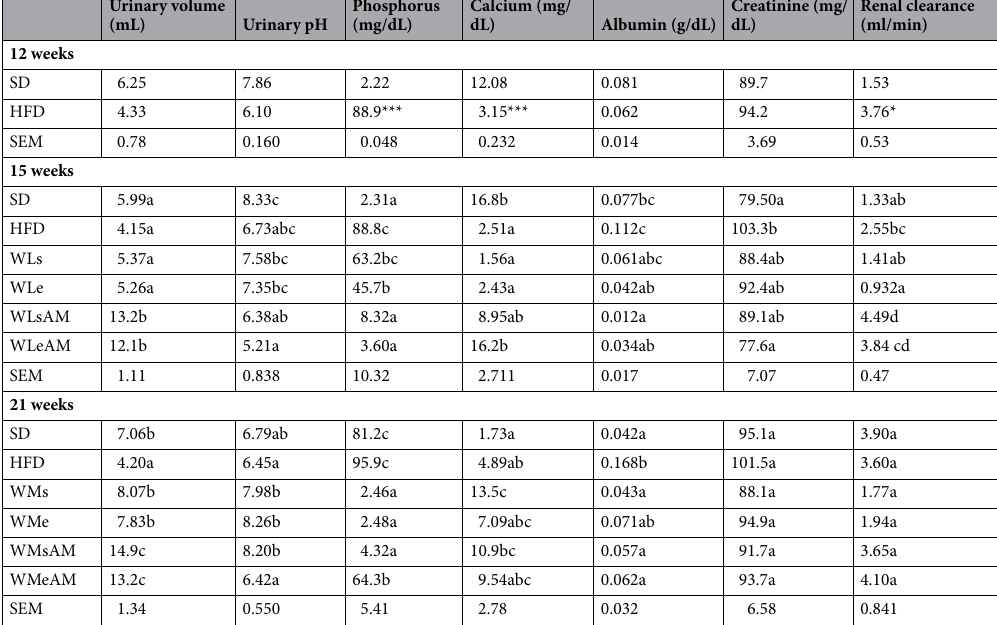
Table 3. Effects of DIO and weight control interventions on urinary parameters of kidney functionality. SD standard rat chow diet, HFD hypercaloric diet for dietary induction of obesity, WLs high protein weight- loss intervention diet with a sedentary lifestyle (weeks 12–15), WLe high protein weight-loss intervention diet with training protocol, WLsAM high protein weight-loss intervention diet with a sedentary lifestyle and pharmacological treatment with AM251, WLeAM high protein weight-loss intervention diet with training protocol and pharmacological treatment with AM251. WMs high protein weight-loss intervention diet with a sedentary lifestyle (weeks 12–15) followed by weight-maintenance stage (weeks 15–21) with SD dietary treatment and sedentary lifestyle, WMe high protein weight-loss intervention diet with training protocol followed by weight-maintenance stage with SD dietary treatment and training protocol, WMsAM high protein weight-loss intervention diet with a sedentary lifestyle and pharmacological treatment with AM251 followed by weight-maintenance stage with SD dietary treatment, sedentary lifestyle, and pharmacological treatment with AM251, WMeAM high protein weight-loss intervention diet with training protocol and pharmacological treatment with AM251 followed by weight-maintenance stage with SD dietary treatment, training protocol, and pharmacological treatment with AM251. Results are means of 8 rats. SEM, standard error of the mean. *P < 0.05, ***P < 0.001 in t-test (12 weeks); a, b, c, means within the same column with different letters are significantly different (ANOVA treatment, P < 0.05; 15 and 21